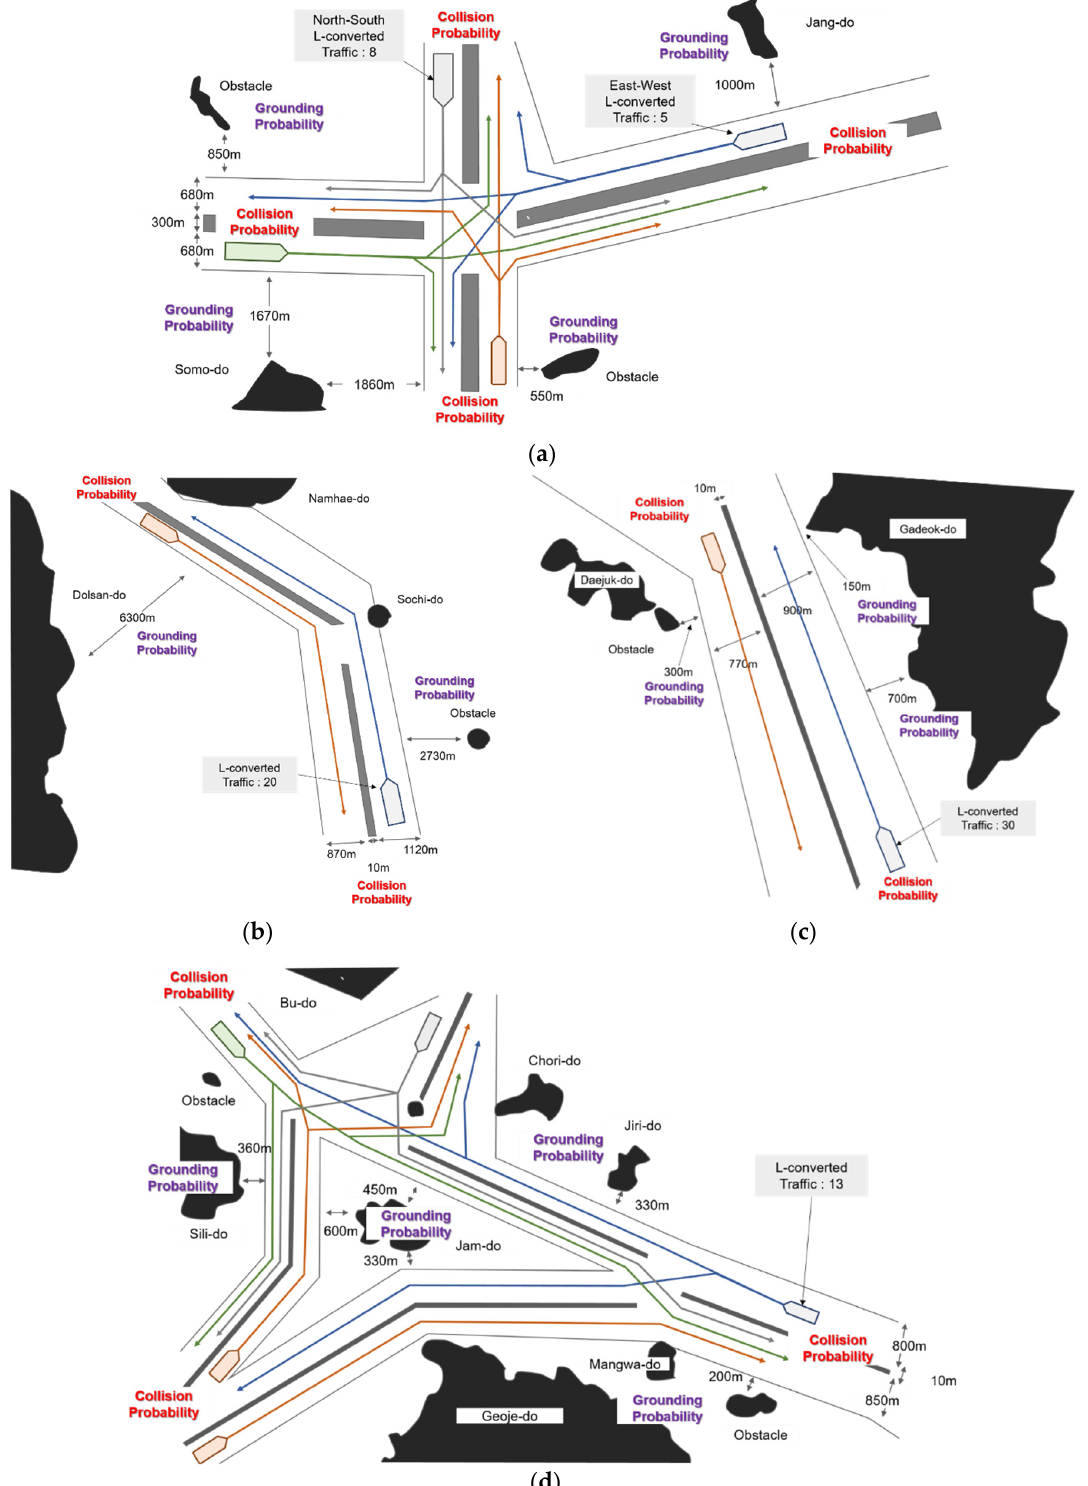
Figure 7. ( a ) Collision risk and grounding probability evaluation scenario of the Wando fairway, ( b ) the Yeosu fairway, ( c ) the Gadeok fairway, and ( d ) the Masan fairway. Table 7. Details of collision and grounding risk assessment parameters.